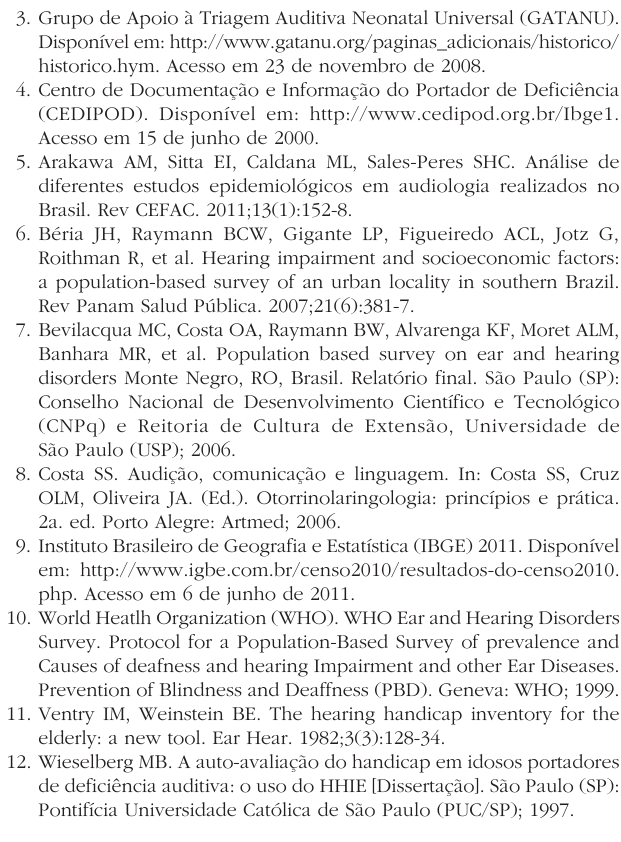
1. Wilson J. Deafness in developing countries. Approaches to a global program of prevention. Arch Otolaryngol. 1985;111(1):2-9. 2. World Health Organization (WHO). Prevention of deafness and hea- ring impairment. Disponível em: http://www.who.int/pbd/deafness/ en/survey_countries.gif. Acesso em 12 de outubro de